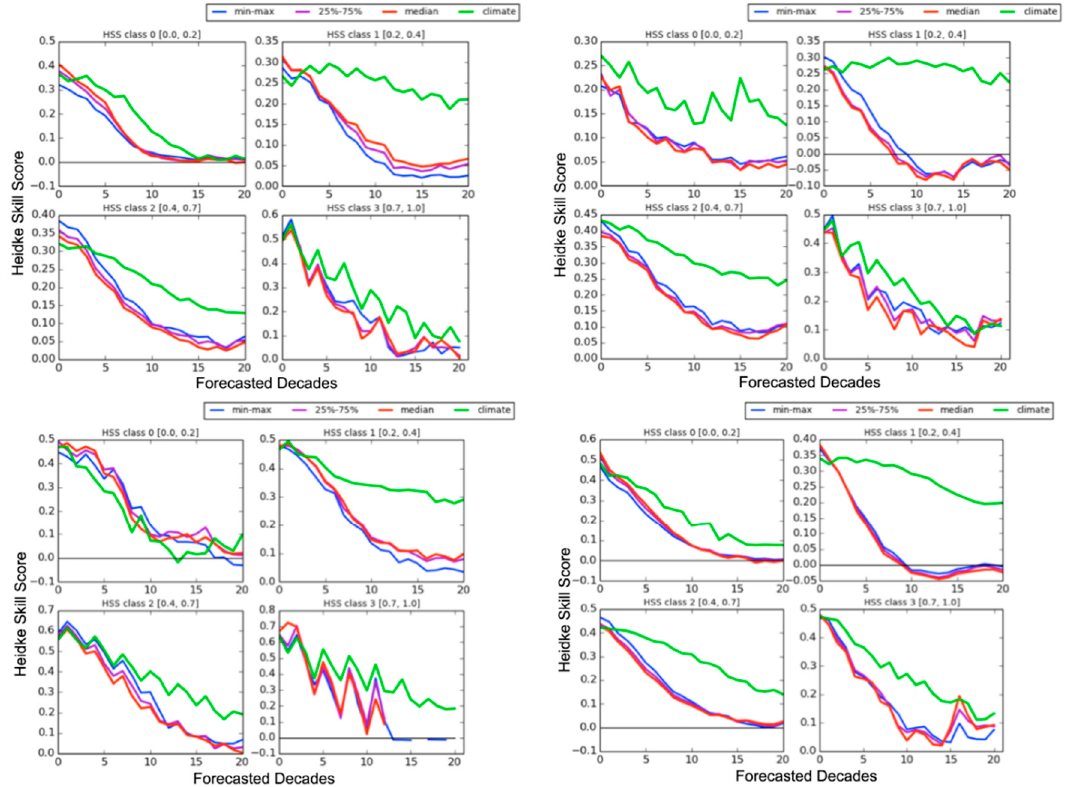
Figure 12. Heidke-Skill-Score (HSS) for the low (0–0.2), medium (0.2–0.4), high (0.4–0.7) and very high (0.7–1) ECDI values, corresponding to extreme, severe, increased and normal drought risk for: Afar ( upper left ); Tigray ( upper right ); Gambela ( lower left ); and Oromia ( lower right ). For every set of 15 ensemble members, the minimum, lower quantile (25%), median, upper quantile (75%) and maximum ECDI value are calculated for the 21 future decades. A HSS of 1 corresponds to the “perfect” forecast. For almost all classes, the climatology (green line) outperforms the forecasted ECDI after two to three decades at the maximum.